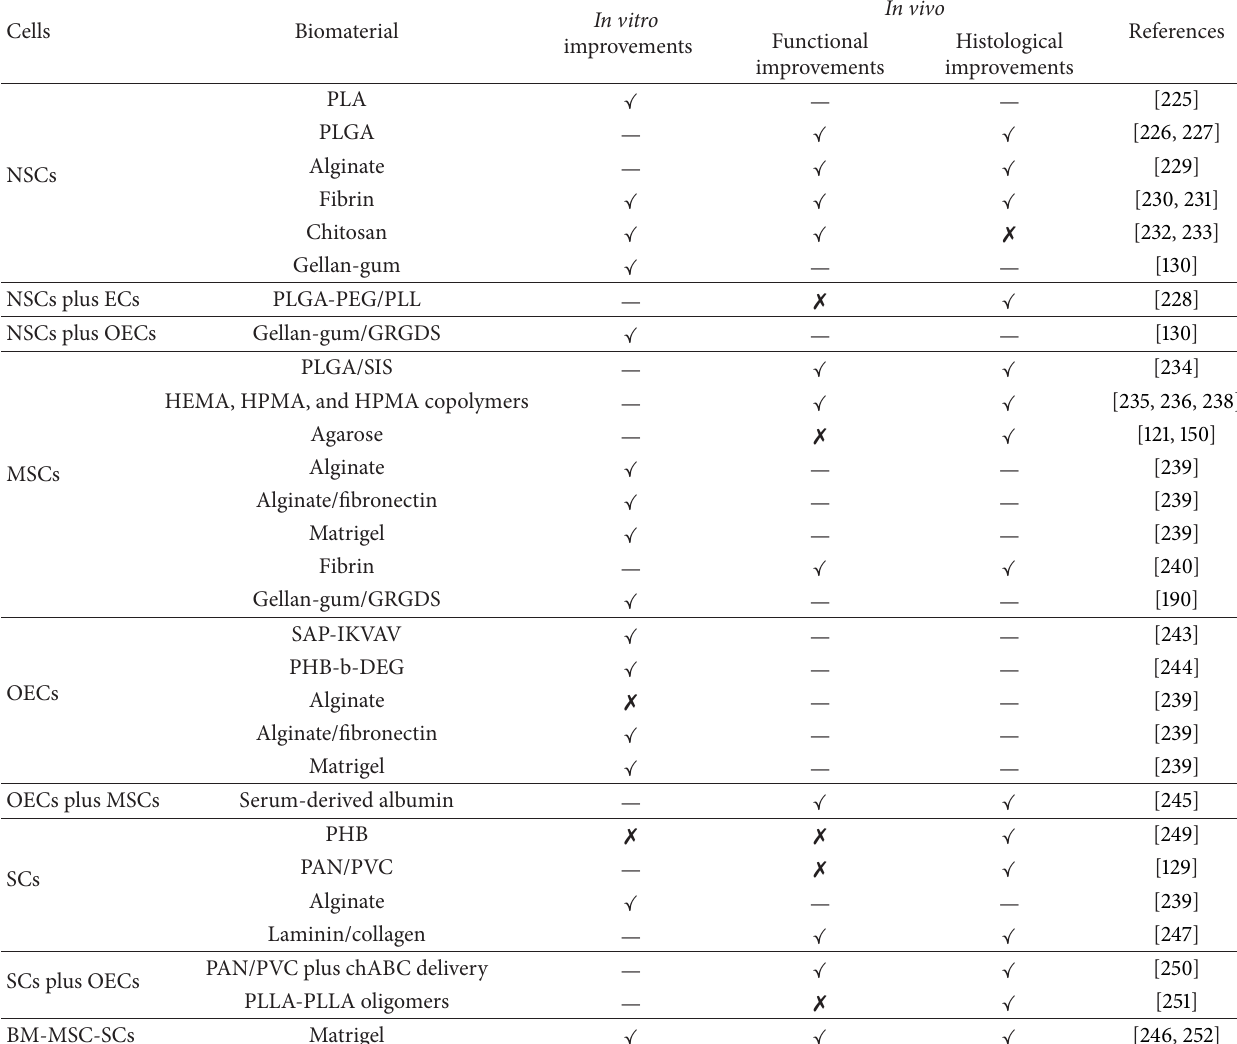
Table 1: Therapeutic potential of combinatorial approaches based on cell therapy and biomaterials for SCI treatment.